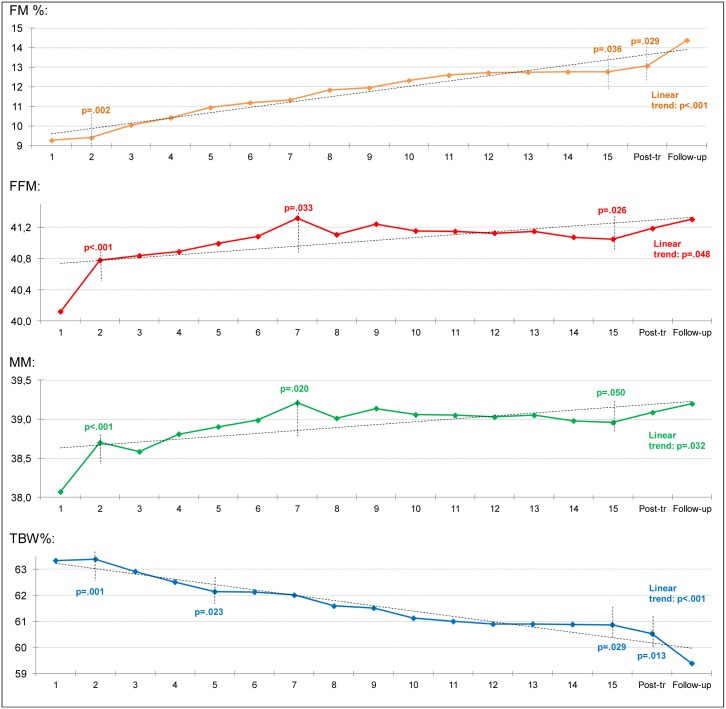
Evolution in body composition in AN patients during treatment.Horizontal dashed-line represents the linear trend and vertical dashed-line indicates a significant change in the slope-trend.